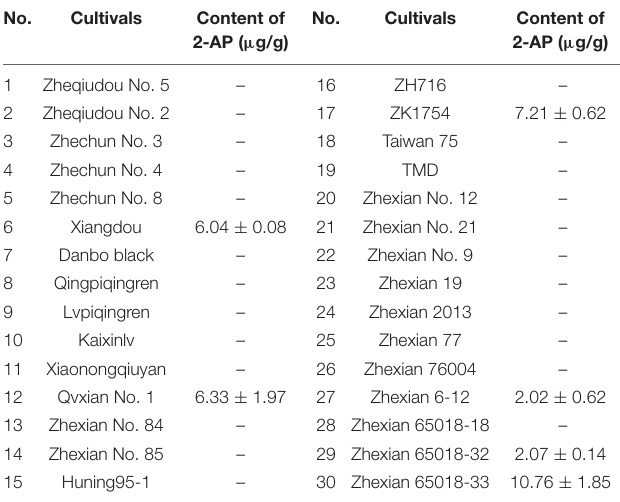
TABLE 3 | 2-acetyl-1-pyrroline (2-AP) content in 30 different vegetable soybean cultivars.